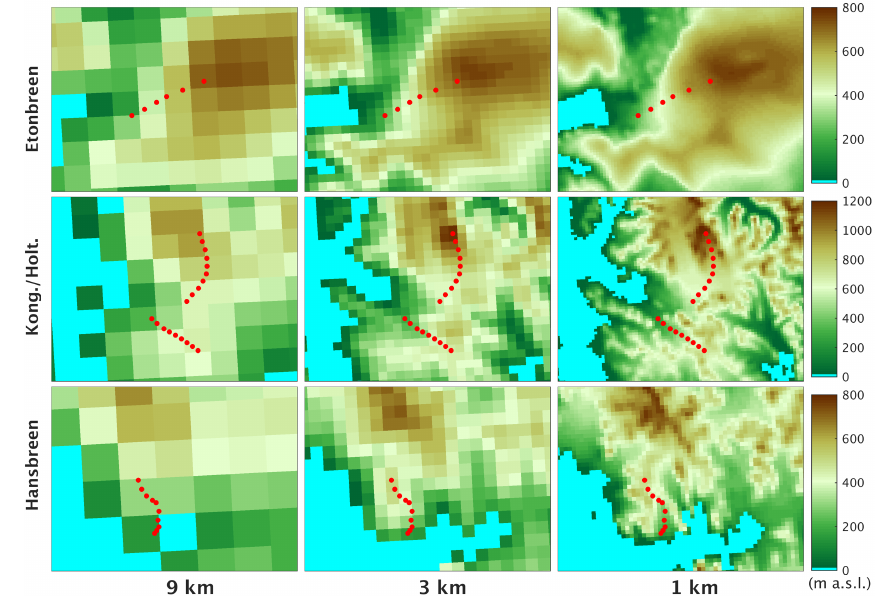
Figure 7. Model topography at 9, 3, and 1km grid spacings around Etonbreen (top), Kongsvegen and Holtedahlfonna (middle), and Hans- breen (bottom). Red dots indicate stake